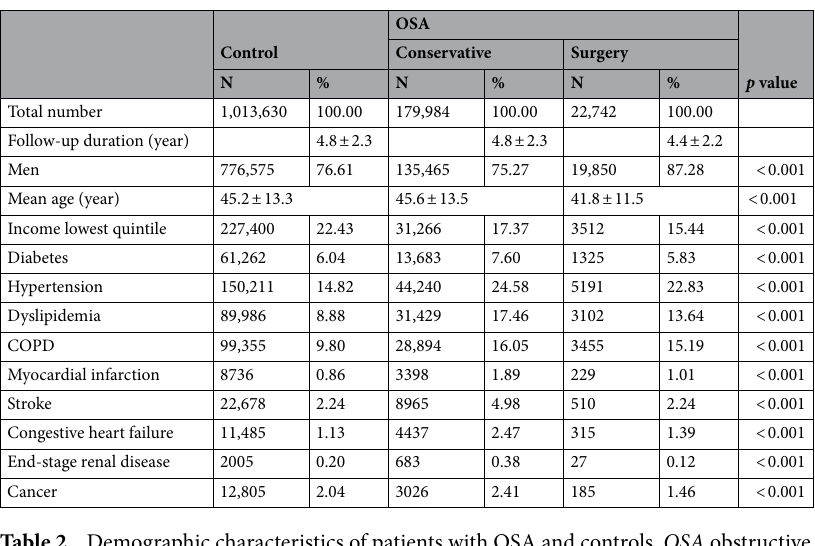
Table 2. Demographic characteristics of patients with OSA and controls. OSA obstructive sleep apnea, COPD chronic obstructive pulmonary disease.